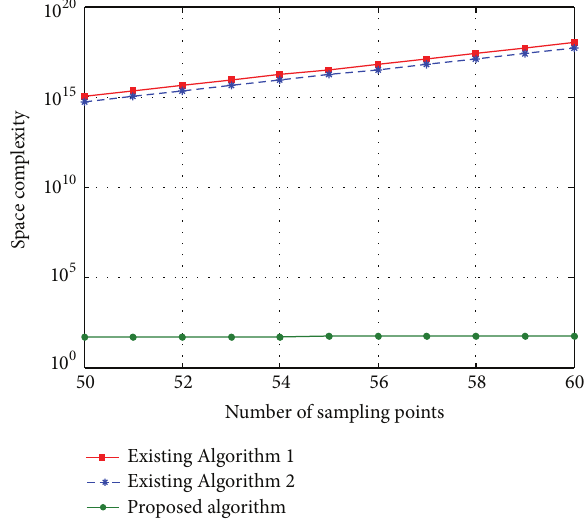
Figure 5: Comparison among proposed algorithm, existing Algo- rithm 1, and existing Algorithm 2 in terms of space